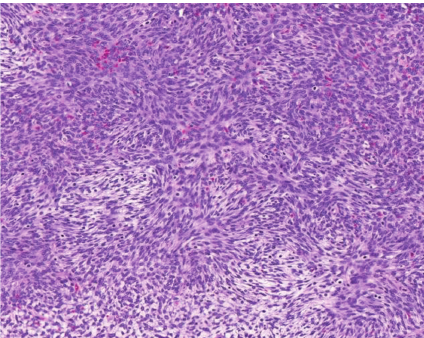
Figure 5: Immunohistochemistry—focal expression of